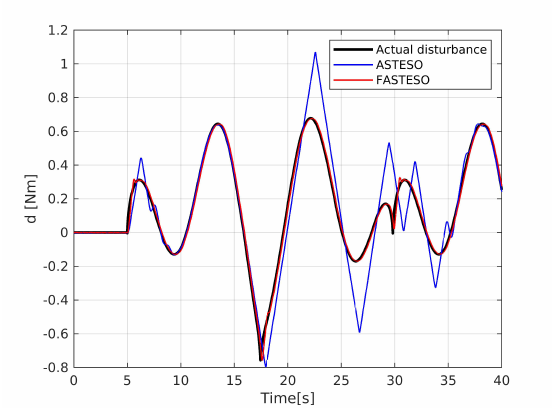
Figure 8. Estimation results from ASTESO and FASTESO with scalar a =